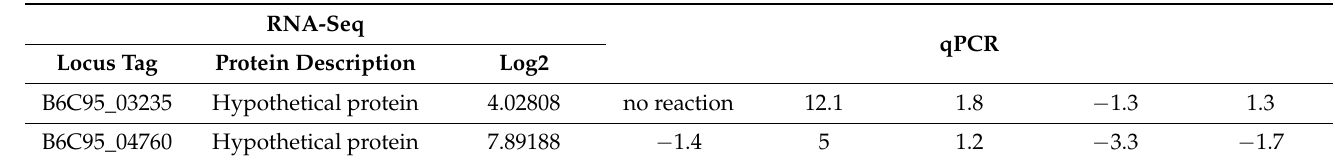
Table 6. Comparison of RNA-seq and qPCR results in S. epidermidis mono-species biofilms under anaerobic conditions.